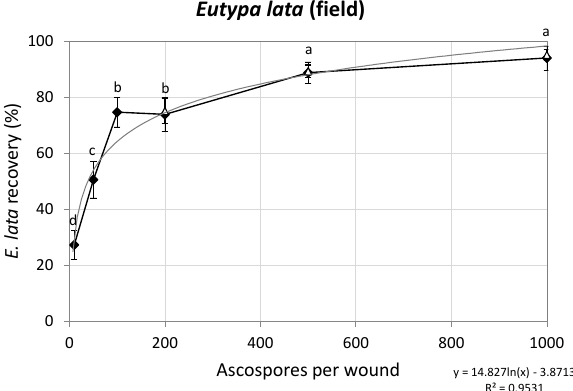
Figure 3. Mean percentage recovery from the field experi - ment (cv. Shiraz) inoculated with Eutypa lata at different in - oculum dosages of 10, 50, 100, 200, 500 or 1000 ascospores/ wound applied once (black rhombus) or twice (2 × 100, 2 × 250 and 2 × 500; white triangles). Ten replications (vines) were used with 10 canes/vine allocated to each inoculum dosage. Significant differences among means ( P <0.05) are indicated by different letters. Bars correspond to the stand - ard error of the mean.